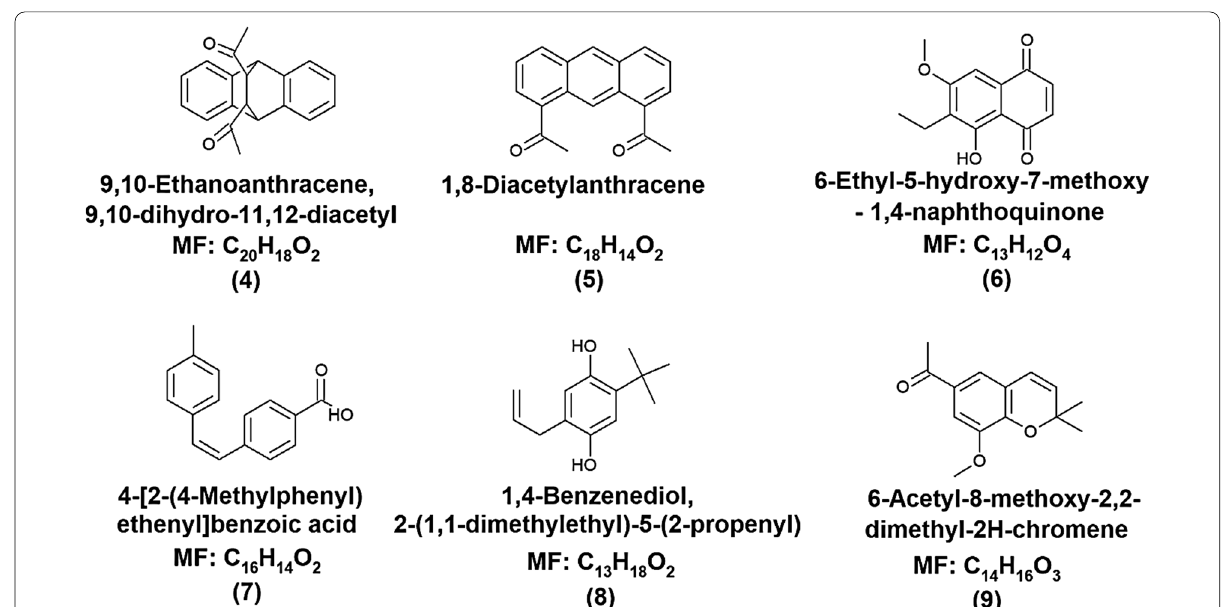
Fig. 5 Some metabolites detected by the GC–MS analysis and are suggested to be intermediates in different biodegradation pathways of anthracene by the selected